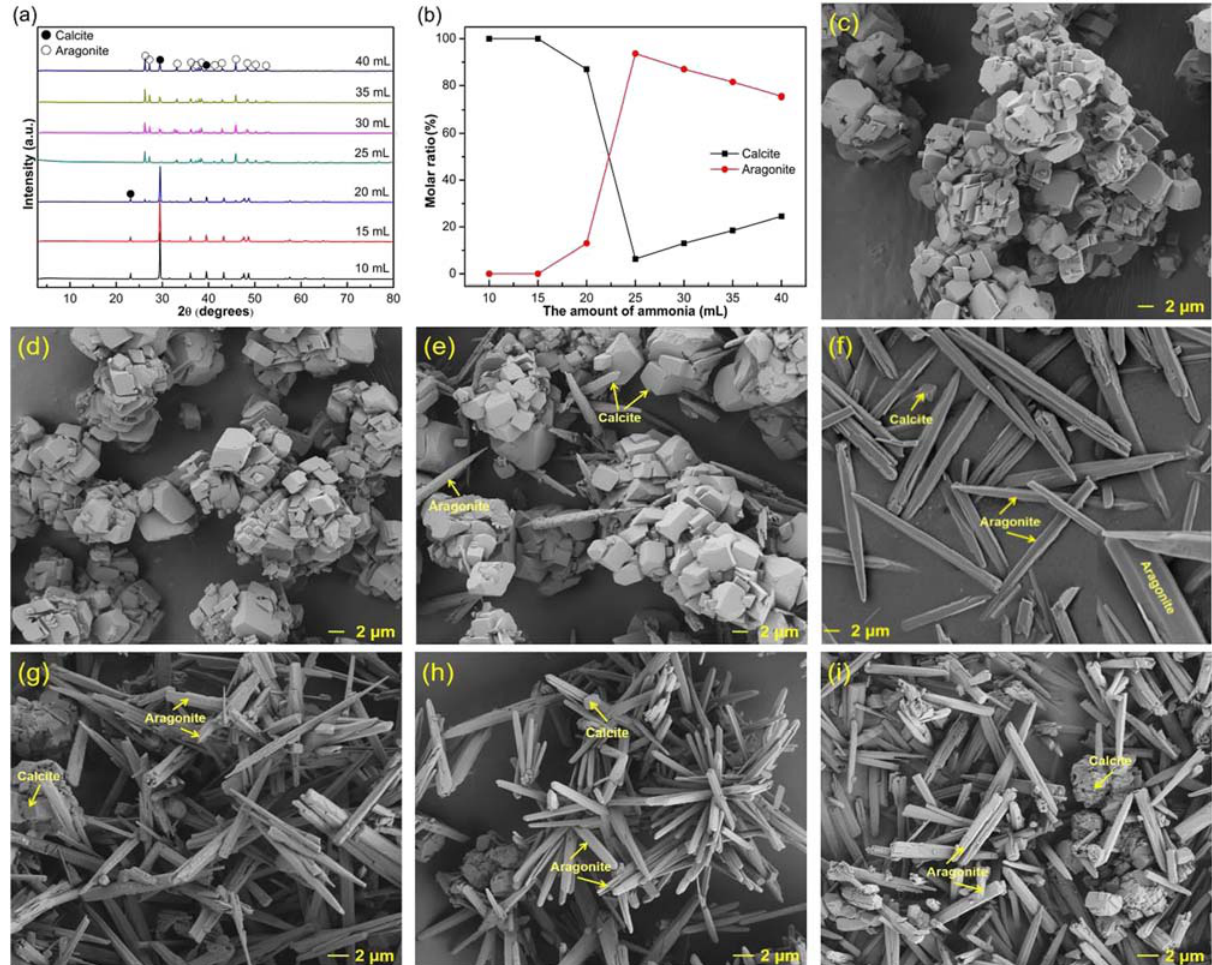
Figure 4: E ff ect of ammonia dosage on crystal phase and morphology: ( a ) XRD patterns of the product, ( b ) composition of the products calcite and aragonite, and SEM images of the product at ( c ) 10 mL, ( d ) 15 mL, ( e ) 20 mL, ( f ) 25 mL, ( g ) 30 mL, ( h ) 35 mL, and ( i ) 40